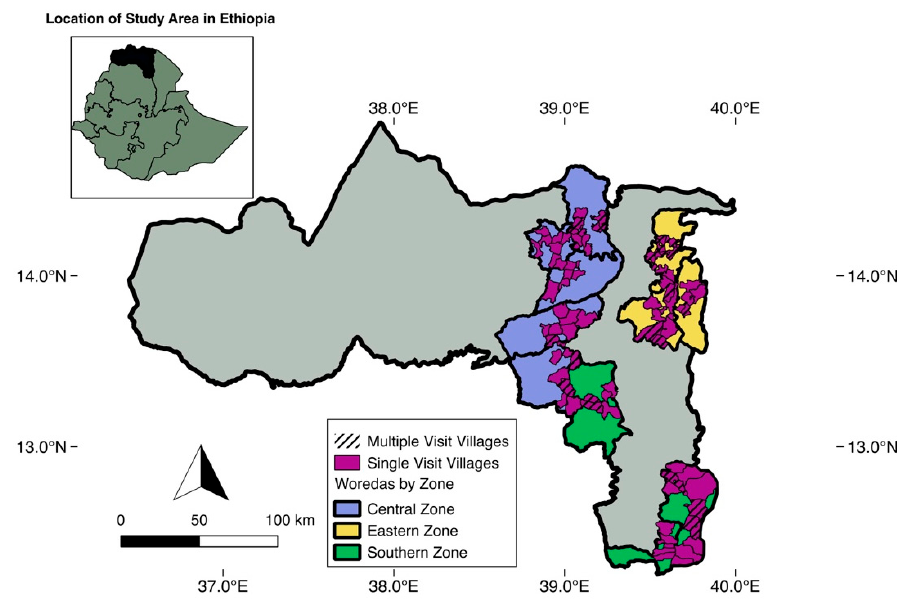
Figure 8. Spatial distribution of the the villages visited, and three zones where observations were recorded.